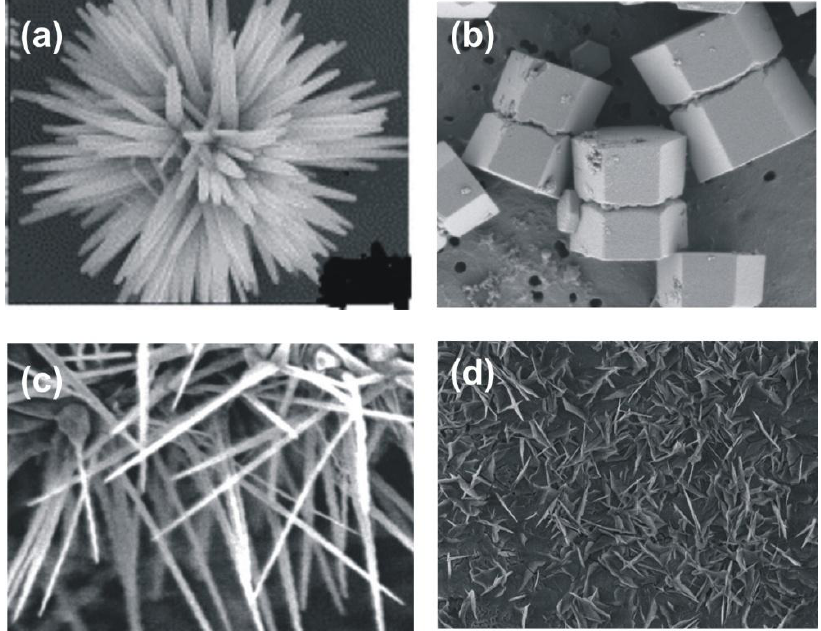
Figure 1. Examples of zinc oxide structure: flower ( a ); rods ( b ); wires ( c , d ) (created based on [17,27,29] with permission from Elsevier Publisher and [11] AIP Publishing